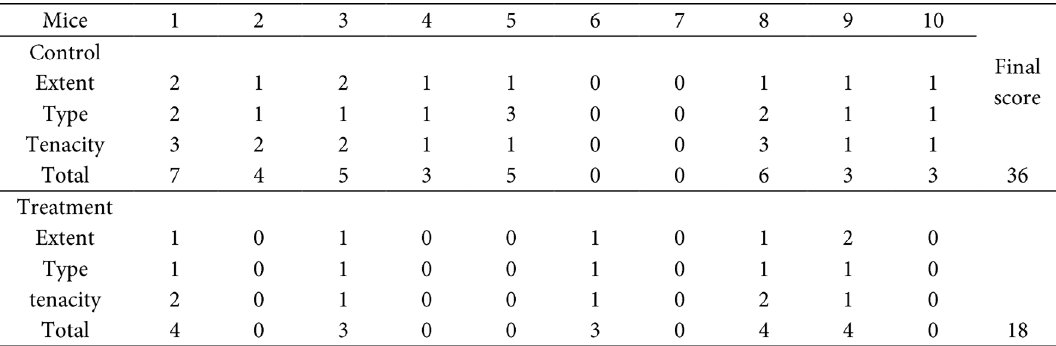
Table 2. Total score of applied scoring system to control and treatment